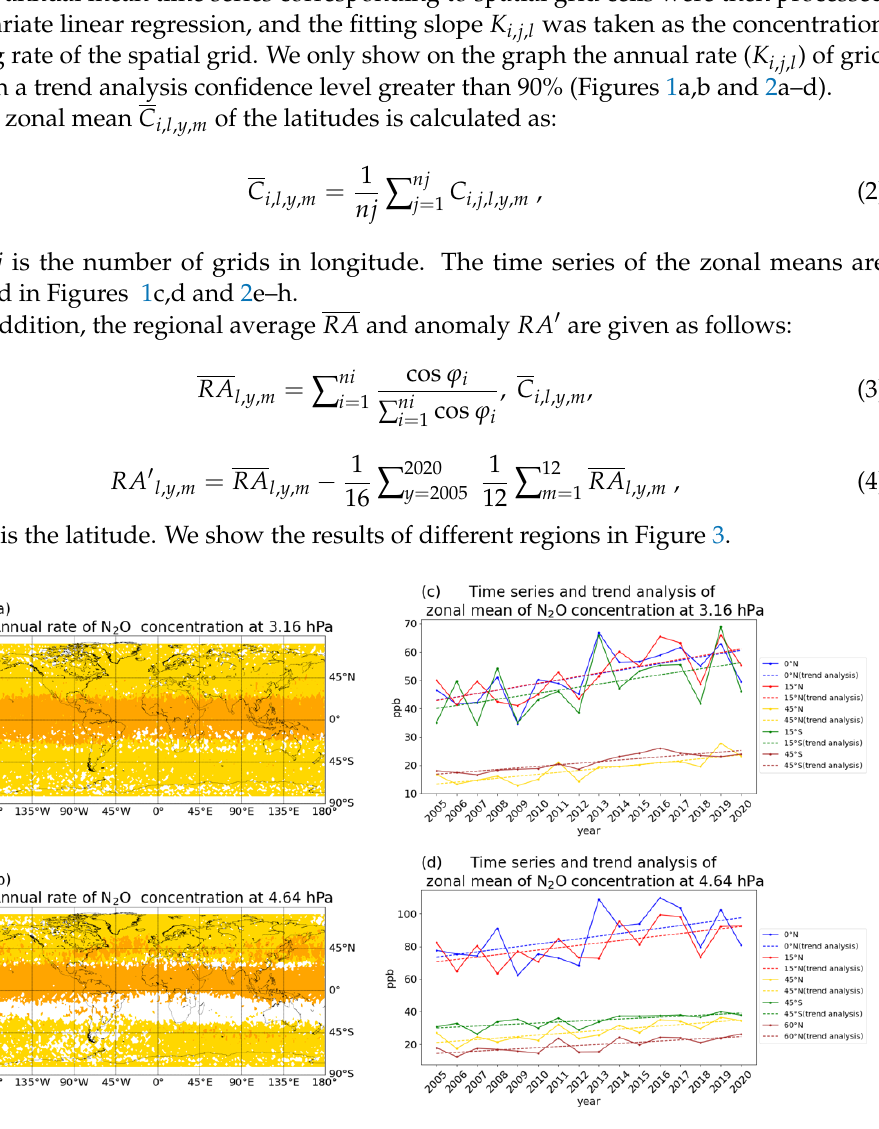
Figure 1. ( a , b ) Annual rate of N 2 O concentration at pressure levels of 3.16 hPa and 4.64 hPa from 2005 to 2020, respectively; ( c , d ) zonal mean time series and trend analysis of N 2 O concentration at pressure levels of 3.16 hPa and 4.64 hPa from 2005 to 2020, respectively. Only trends with a confidence level greater than 90% are shown on the graph.